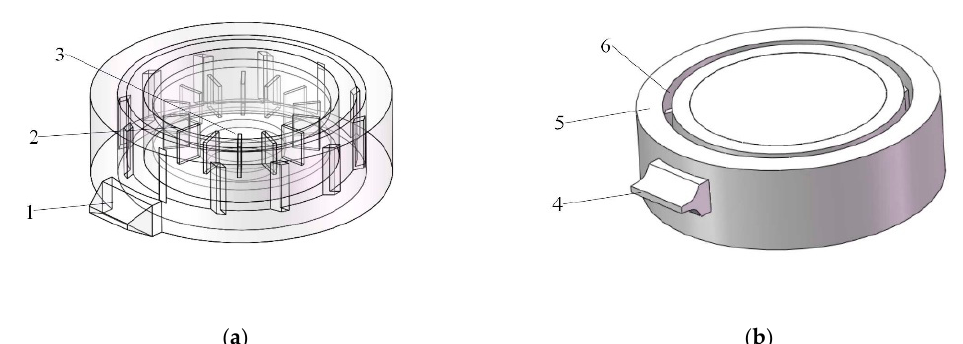
Figure 3. 3D model of the fan runner: ( a ) linear reduction outlet in the lower part. 1. linear area reduction outlet or Laval nozzle (shrinkage section) outlet in the lower part 2. impeller 3. inlet; ( b ) Laval outlet on the symmetric plane. 4. linear area reduction outlet or Laval nozzle (shrinkage section) outlet on the symmetric plane 5. passageway 6. worm casing.